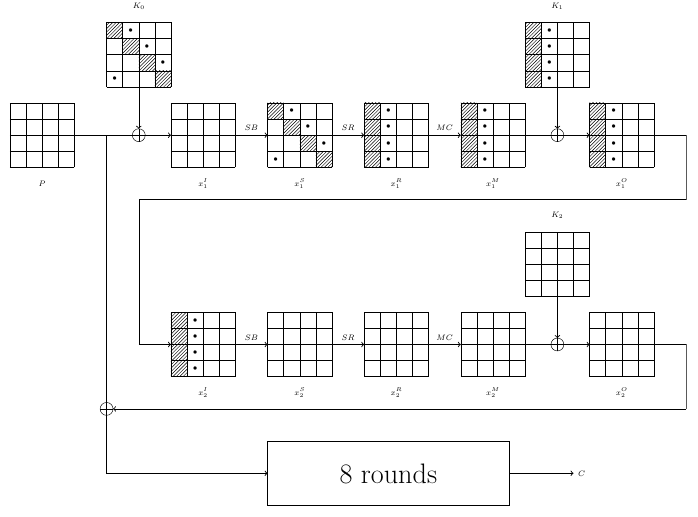
Figure 20: Key-recovery attack for Dual-AES-PRF 2 , 8